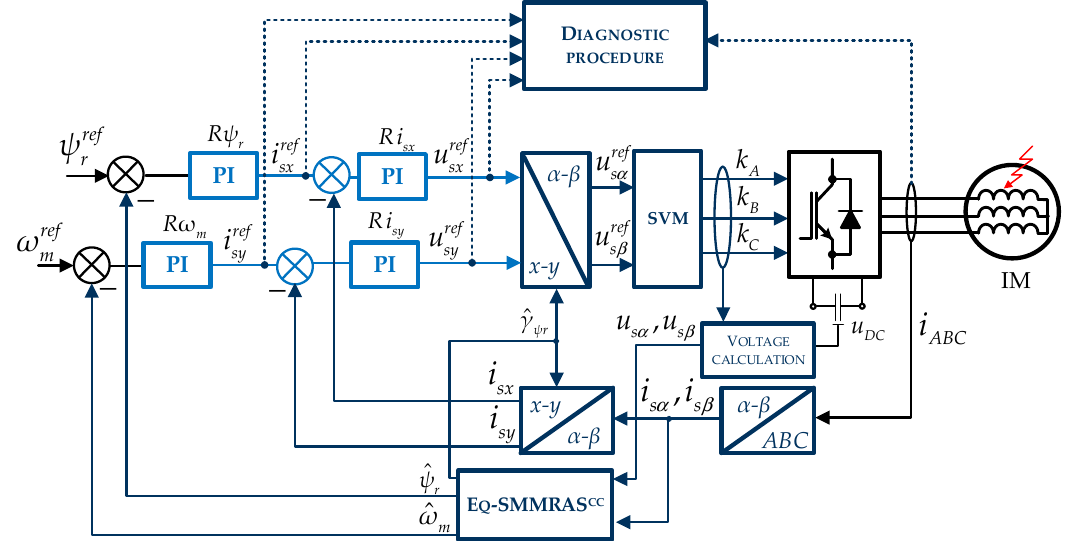
Figure 2. Block diagram of sensorless direct field oriented control (DFOC) structure for IM. PI: proportional-integral, Eq-SMMRAS CC : Equivalent (Eq)-Sliding Mode Model Reference Adaptive System (superscripts C-current measurement, C-rotor flux estimation based on current measurement), SVM: space vector modulation